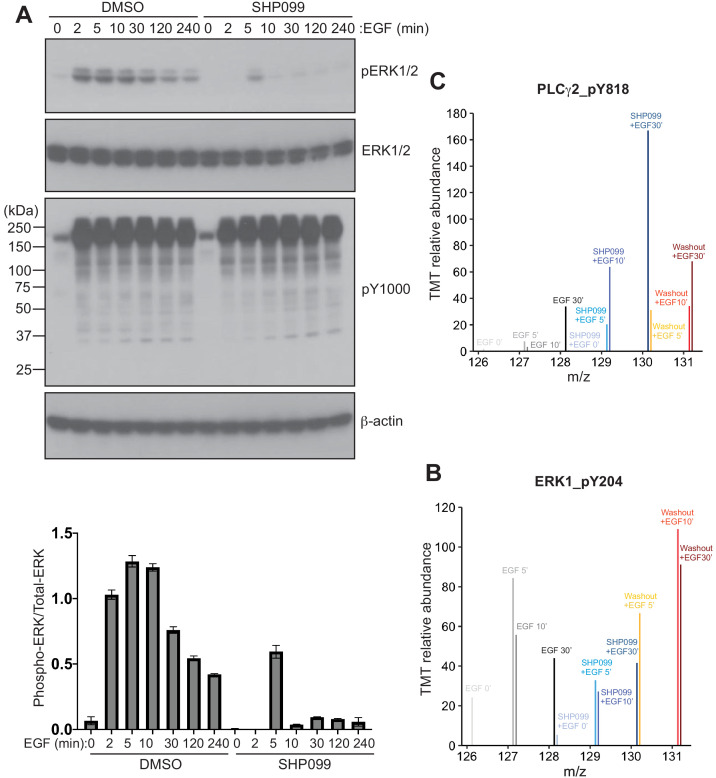
Time course of ERK induction after EGF stimulation and phosphoproteomic data for ERK1 and PLCG2.(A) Top: Western blot showing the time course of the phosphoERK1/2 response after EGF stimulation. Bottom: Quantification of the ratio of pERK/ERK band intensities, relative to the ratio at t = 2 min. (B, C) TMT relative abundance plotted as a function of peptide m/z values from MS3 spectra, showing quantification of ERK1 (B) and PLCG2 (C) phosphopeptides.Figure 1—figure supplement 1—source data 1.Table showing phospho-ERK1/2 levels normalized to total-ERK1/2 levels (as quantified by measuring band intensities using ImageJ) in MDA-MB-468 cells treated with SHP099 and EGF as indicated.Figure 1—figure supplement 1—source data 2.Table showing peptide m/z values and TMT relative abundance values from MS3 spectrum of ERK1 phosphopeptide.Figure 1—figure supplement 1—source data 3.Table showing peptide m/z values and TMT relative abundance values from MS3 spectrum of PLCγ2 phosphopeptide.